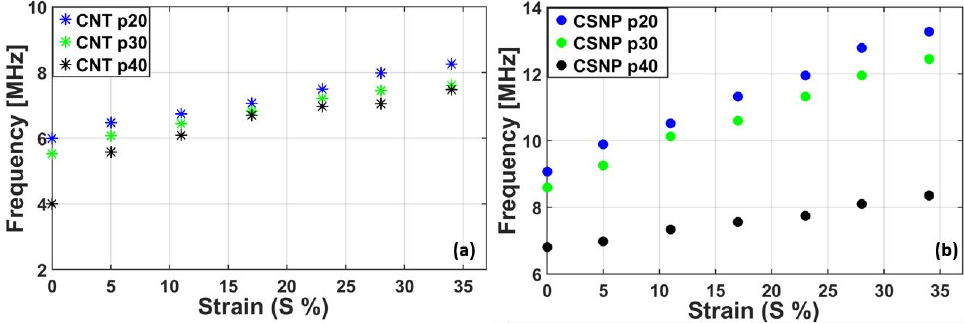
Figure 6. Center frequencies for the PA pressure outputs shown in Figure 5. ( a ) CNT-PDMS, ( b ) CSNP-PDMS.